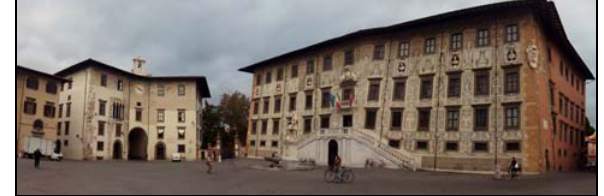
Figure 6 – Panoramic view from Piazza dei Cavalieri with “Pallazo dell’Orologio” (at the left) and “Scuola Normale Superiore” Headquarter (at the right).